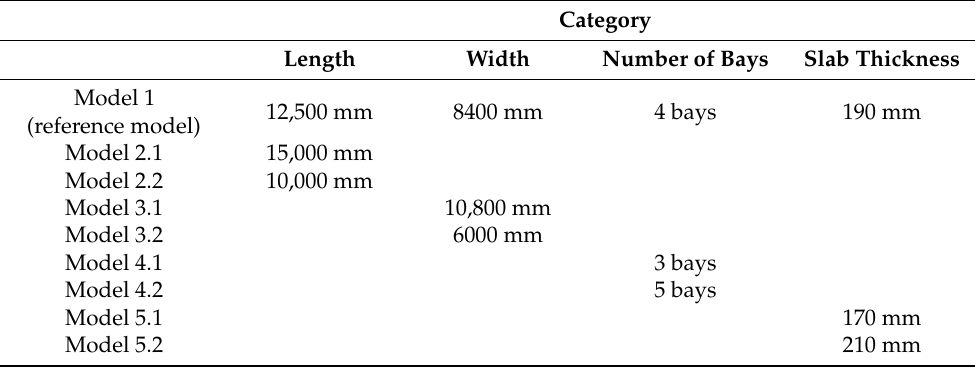
Table 3. Geometric properties under 4 categories.